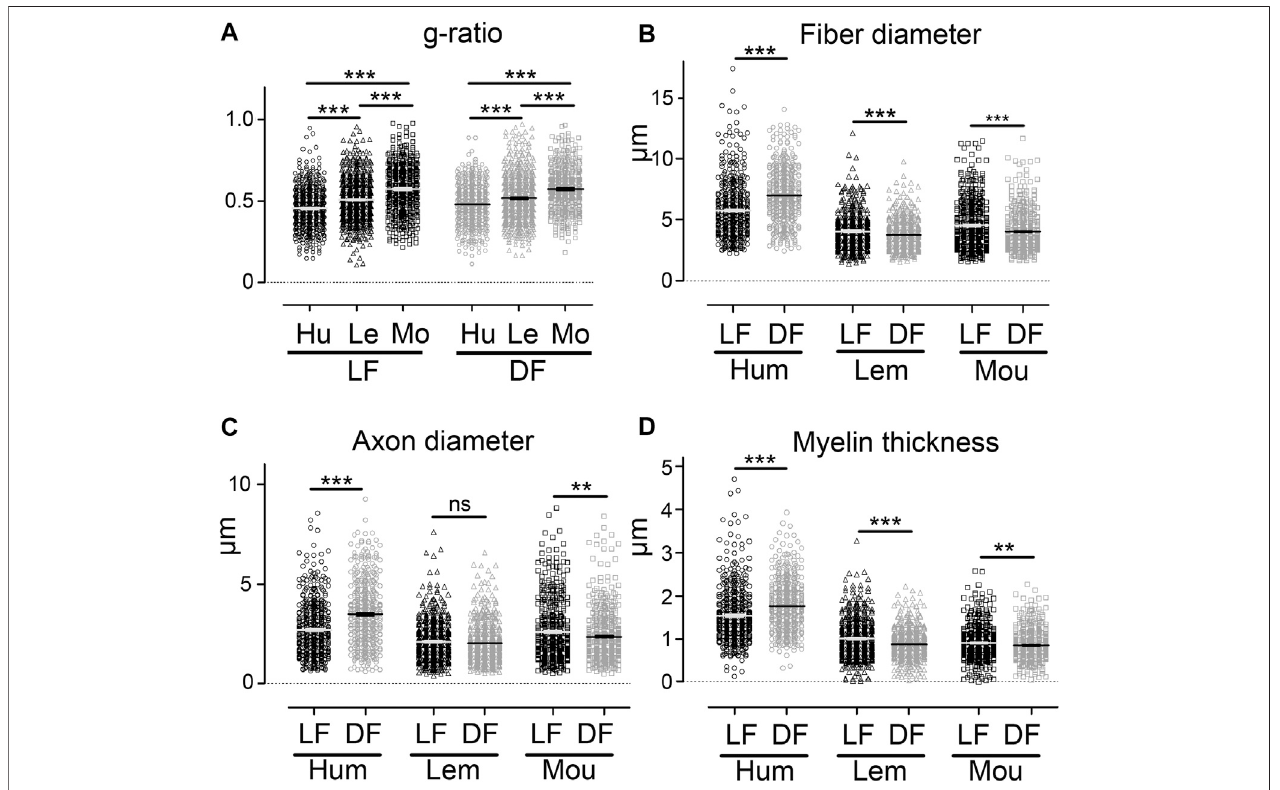
FIGURE 3 | Comparison of g-ratio, fi ber diameter, axon diameter, and myelin thickness between species using CARS microscopy . Comparison of g-ratio in the lateral and dorsal funiculi in between humans, lemurs, and mice (A) . Comparison of fi ber diameter in the lateral and dorsal funiculi in humans, lemurs, and mice (B) . Comparison of axon diameter in the lateral and dorsal funiculi in humans, lemurs, and mice (C) . Comparison of myelin thickness in the lateral and dorsal funiculi in humans,lemurs,andmice (D) .Hu:human,Le:lemurs,andMo:mice.Dataaremean ± SEMpersection.*** p < 0.001,** p < 0.01 ns:non-signi fi cant;unpaired t -test with Welch ’ s correction. Number of fi bers analyzed: n is at least 432 and up to 681 per group.